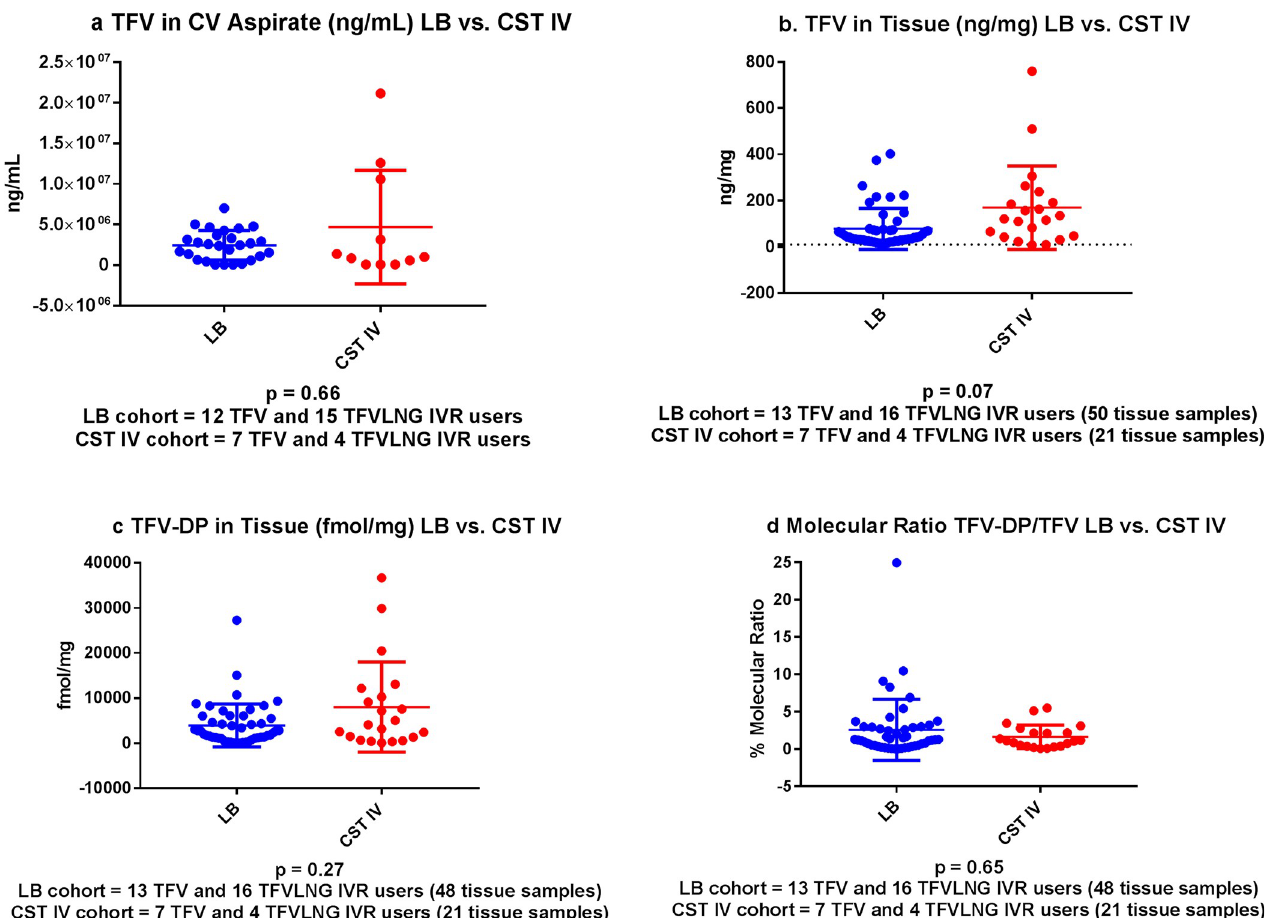
Fig 4. A. TFV concentrations in the CV aspirate among active IVR users with Lactobacillus dominated (LB) CSTs versus CST IV. LB cohort (blue dots) includes 12 TFV and 15 TFV/LNG IVR users. CST IV cohort (red dots) includes 7 TFV and 4 TFV/LNG IVR users. B. TFV concentrations in vaginal tissue among active IVR users with Lactobacillus dominated CSTs (LB) versus CST IV. LB cohorts (blue dots) includes 13 TFV and 16 TFV/LNG IVR users contributing 50 tissue samples. CST IV cohort (red dots) includes 7 TFV and 4 TFV/LNG IVR users contributing 21 tissue samples. C. TFV-DP concentrations in vaginal tissue among active IVR users with Lactobacillus dominated CSTs (LB) versus CST IV. LB cohort (blue dots) includes 13 TFV IVR and 16 TFV/LNG IVR users contributing 48 tissue samples. CST IV cohort (red dots) includes 7 TFV IVR and 4 TFV/LNG IVR users, contributing 21 tissue samples. D. Molecular ratio of TFV-DP to TFV in vaginal tissue among active IVR users with Lactobacillus dominated CSTs (LB) versus CST IV. LB cohort (blue dots) included 13 TFV IVR and 16 TFV/LNG IVR users and contributed 48 vaginal tissue samples. CST IV cohort (red dots) included 7 TFV IVR and 4 TFV/LNG IVR users contributing 21 vaginal tissue